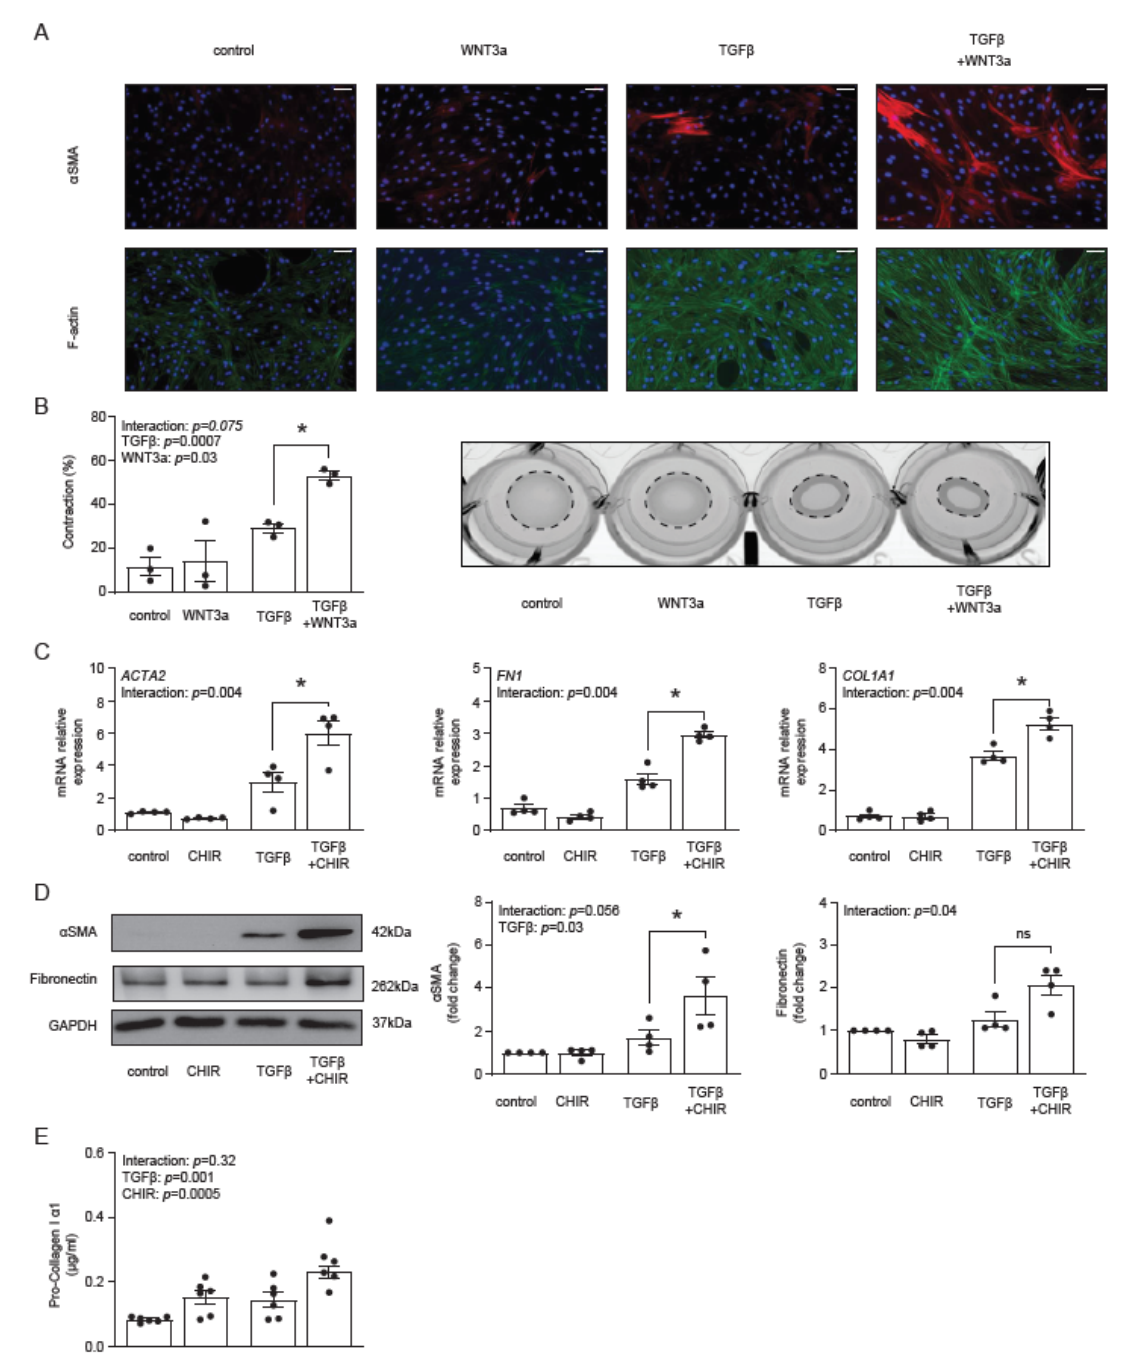
Figure 3. Panel ( A ) illustrates representative immunocytochemistry staining of α SMA, F-actin and cell nuclei (DAPI) of cardiac fibroblasts stimulated with WNT3a and/or TGF- β for 72 h. Data are representative of three biological independent experiments. Bar = 100 µ m. Panel ( B ) shows quantification of gel contraction (72 h, n = 3) and representative image of collagen gel containing cardiac fibroblasts pre-treated as indicated. Panels ( C–E ) describe the profibrotic effect of GSK3 β inhibitor CHIR99021 (CHIR) in the presence or absence of TGF- β in cardiac fibroblasts. Expression of profibrotic genes after 72 h of stimulation is presented in panel ( C ) ( n = 4). Panel ( D ) shows representative immunoblots and the respective quantifications of α SMA and fibronectin after 72 h of stimulation (all n = 4) and panel ( E ) indicates pro-collagen I α 1 level in supernatants ( n = 6) stimulated for 5 days. Bars and whiskers represent means ± SEM. Main effect of WNT3a/CHIR, TGF- β and their interaction were tested using two-way ANOVA followed by Tukey’s multiple comparisons test, when the p -value for interaction wa s ≤ 0.1; * p < 0.05 (post-hoc TGF- β vs. TGF - β+WNT3a or CHIR vs. TGFβ+CHIR).